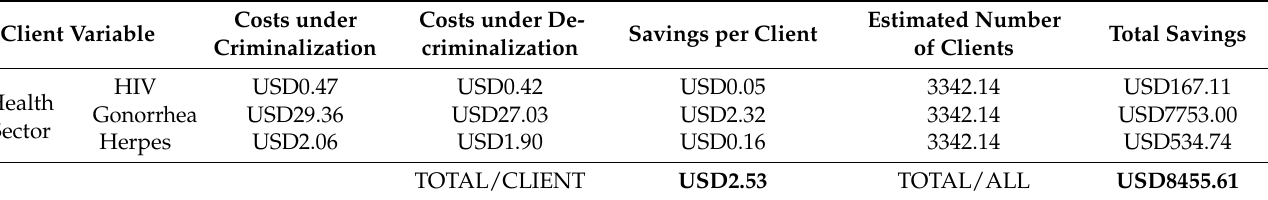
Table 14. Total annual cost savings from clients following decriminalization of sex work in DC (monetary values in 2020 USD).